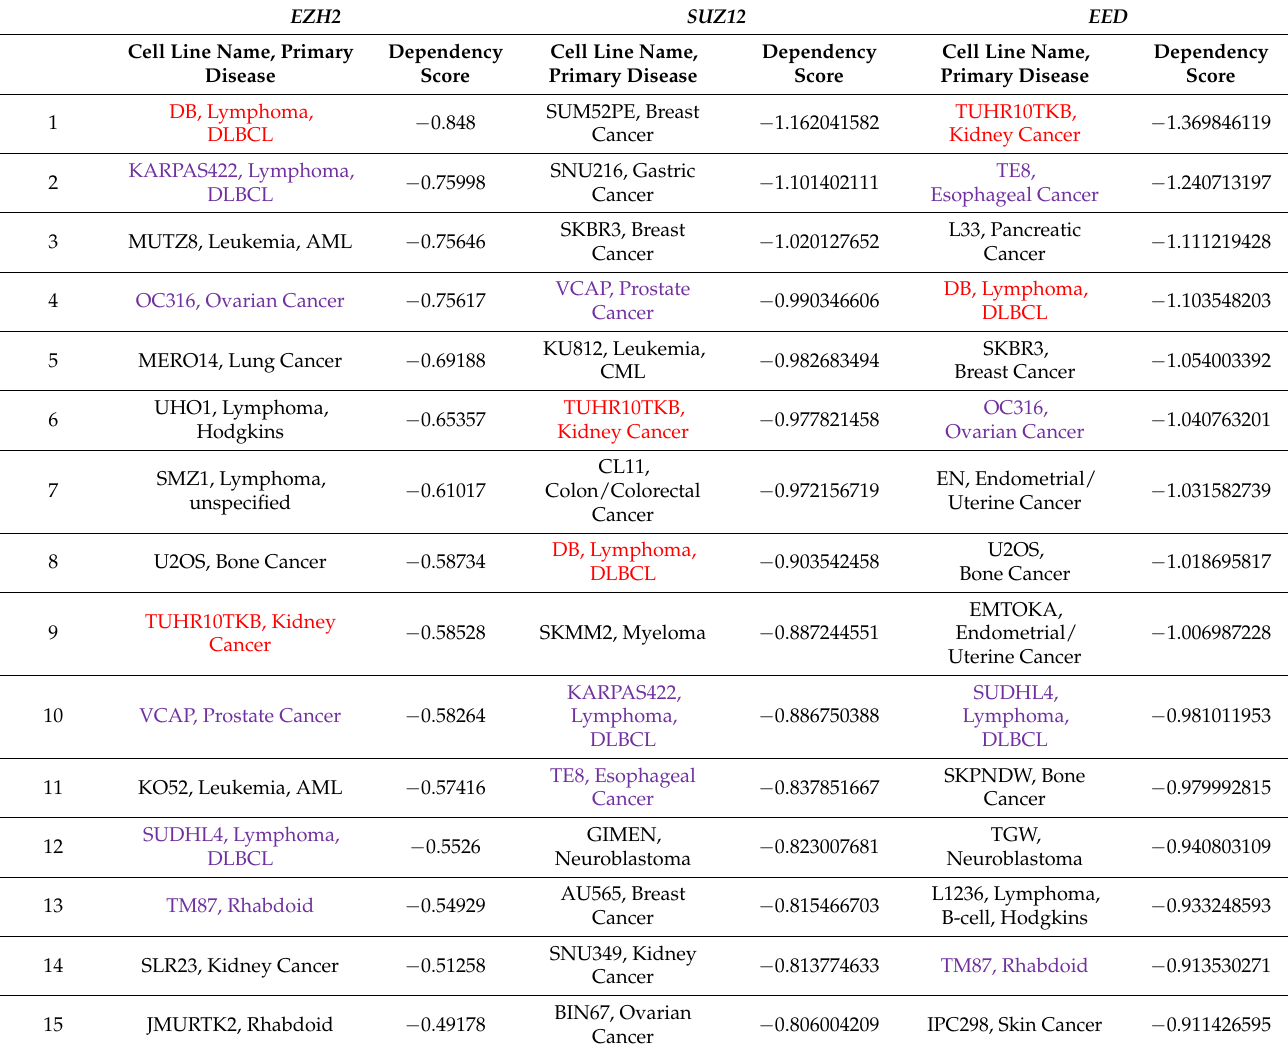
Table 3. Top cell lines most sensitive to EZH2 , SUZ12, and EED knockouts by CRISPR/Cas9. Red—cancer cell lines present in TOP15 sensitive upon depletion of any PRC2 subunit; purple—present in case of depletion of any of two of PRC2